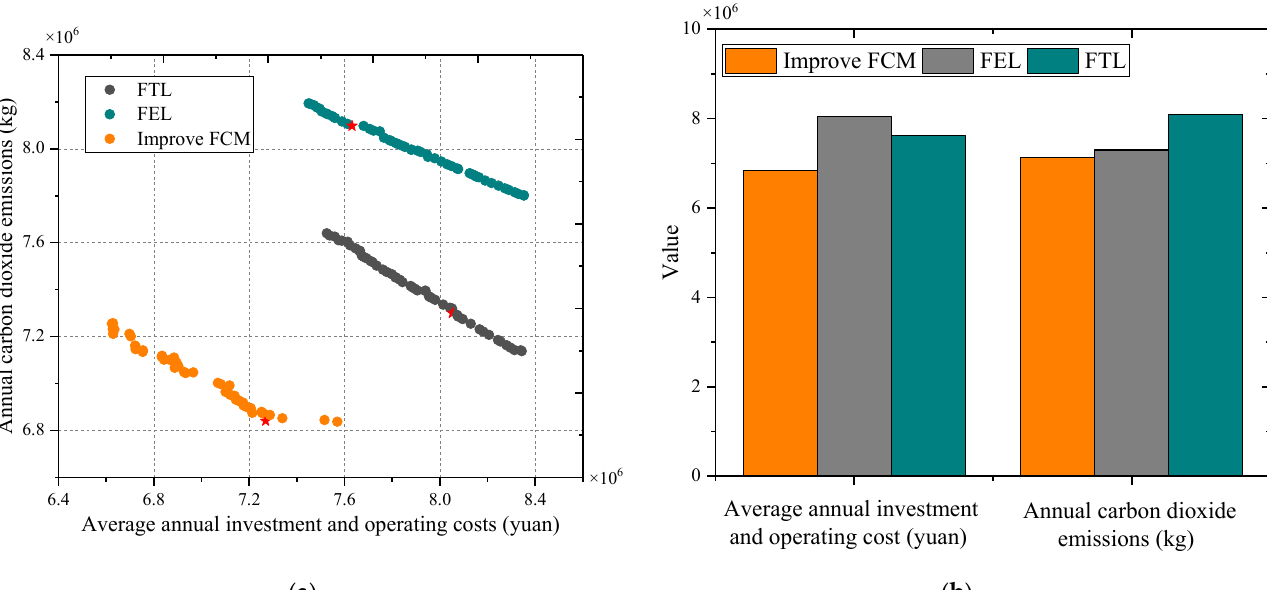
Figure 13. ( a ) Single-level optimized Pareto solution set; and ( b ) best solution.